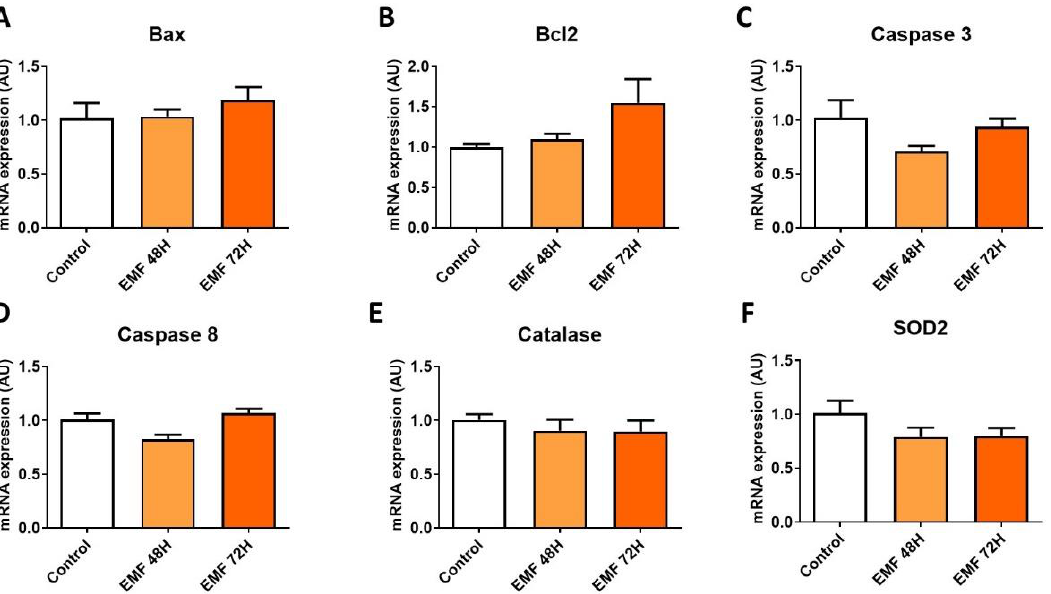
Figure 6. Gene expression profile of antioxidant enzymes and apoptosis-related factors in mice subjected to EMFs. Quantitative analysis of the mRNA expression levels of Bax ( A ), Bcl2 ( B ), caspase 3 ( C ), caspase 8 ( D ), catalase ( E ), and SOD2 ( F ) in mice exposed to 915 MHz EMFs for 48 h and 72 h and control animals. The results present the mean ± SEM, n = 6 – 10.